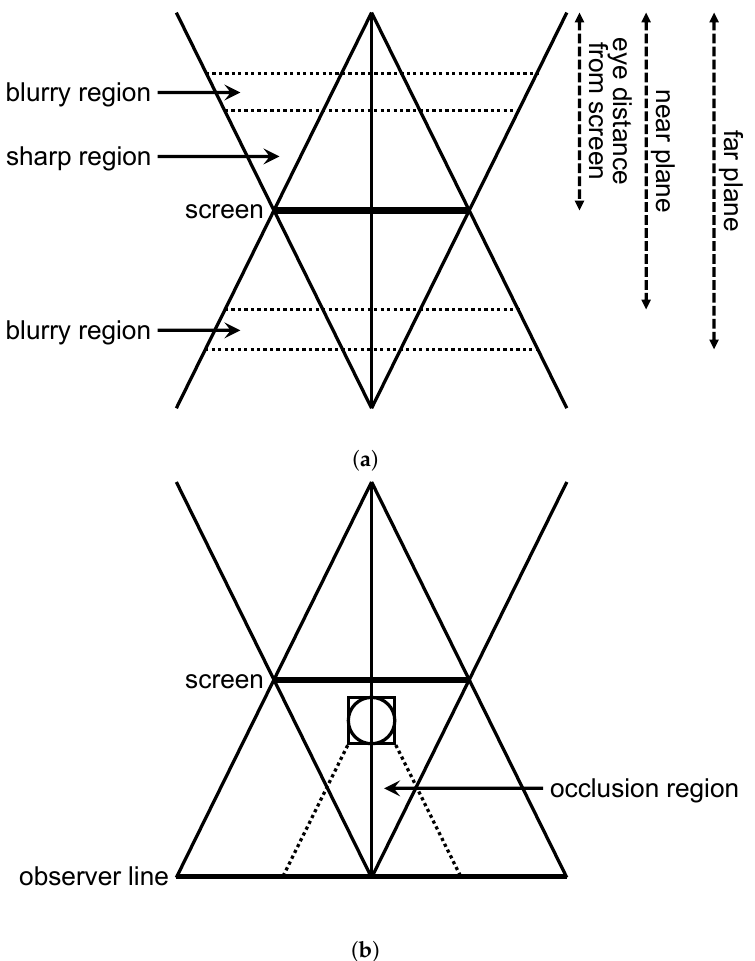
Figure 7. Blurry and occlusion metrics for light field visualization (based on [68]). ( a ) Blurry regions. ( b ) Occlusion